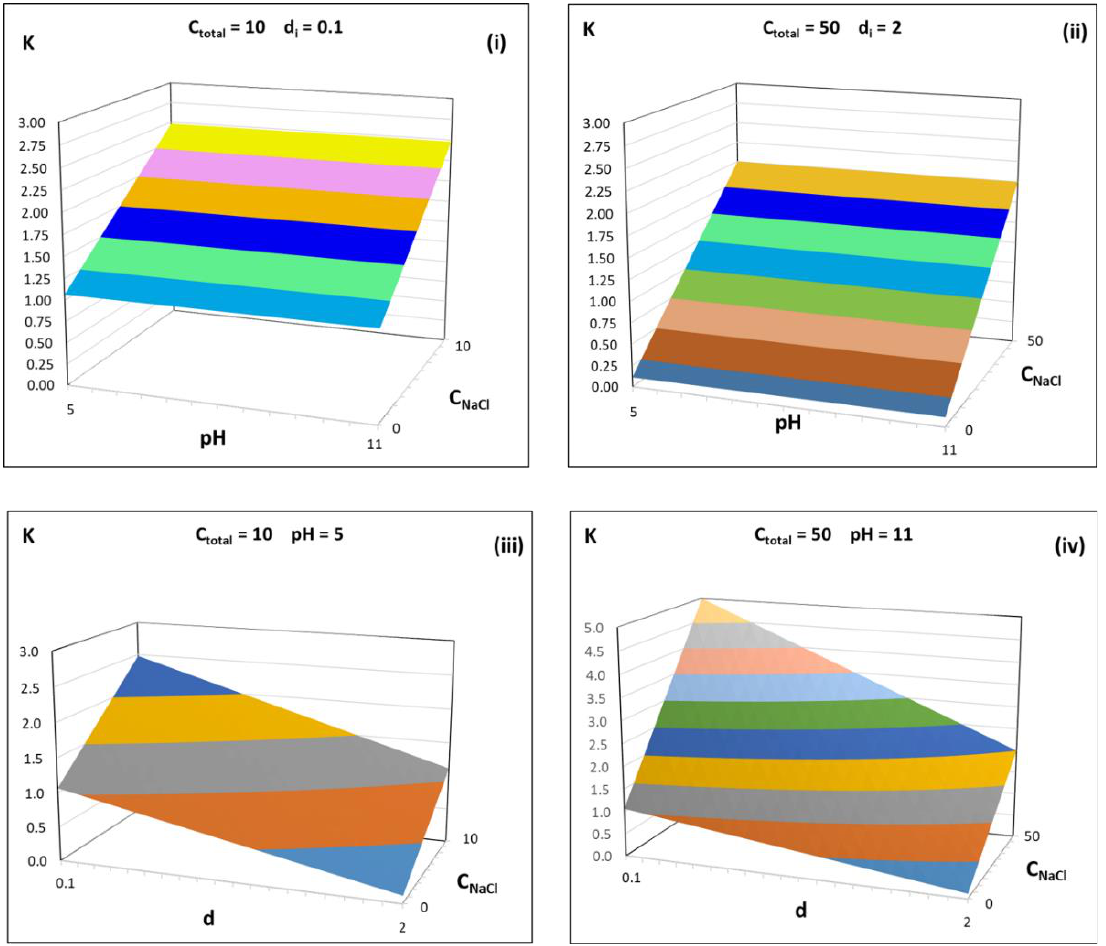
Figure 5. Modelized values for pH, d i , C NaCl , and C total . ( i ) C total =10 and d i = 0.1; ( ii ) C total =50 and d i = 2.0; ( iii ) C total =10 and pH = 5; ( iv ) C total =50 and pH =